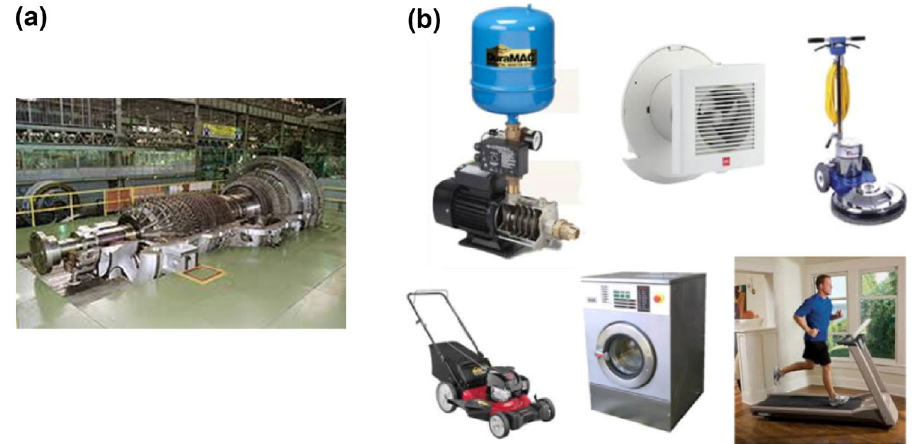
Fig. 7 Power plant gas turbine (a) and typical residential machines